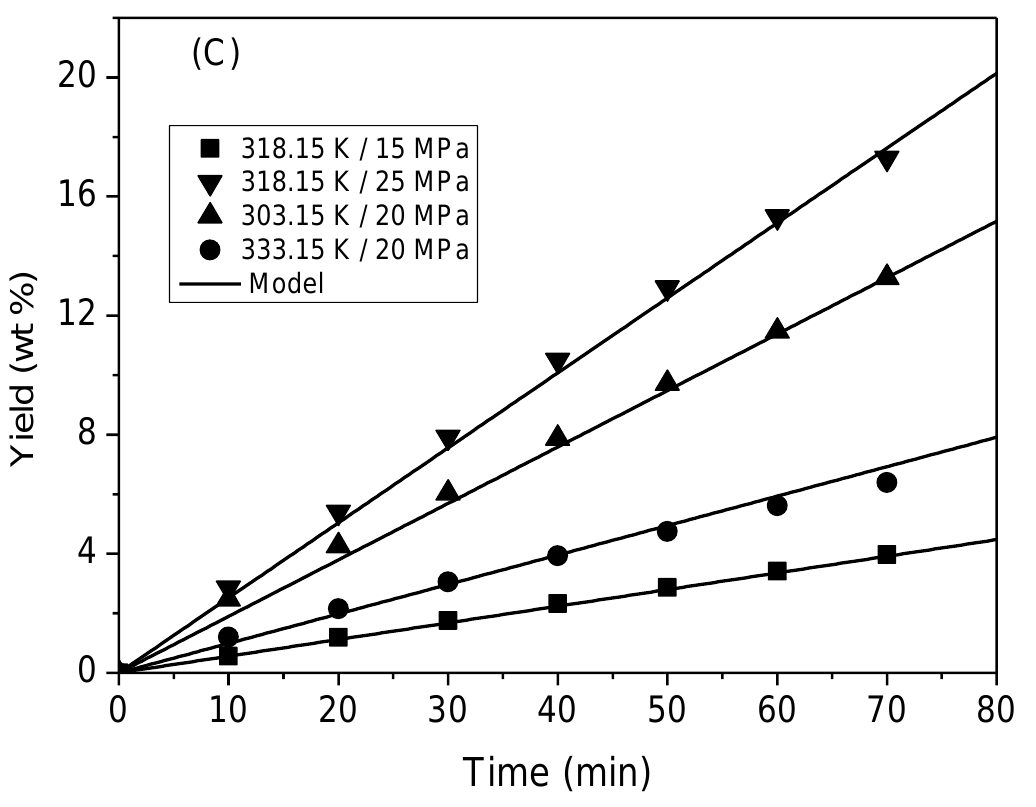
Figure 1. Experimental kinetic curves for pequi almond oil extraction with supercritical CO 2 fitted using the second-order model. Flow rates of ( A ) 2.0 g.min − 1 , ( B ) 3.5 g.min − 1 , and ( C ) 5.0 g.min − 1 . In general, increasing the CO 2 flow in the extractor bed facilitated oil